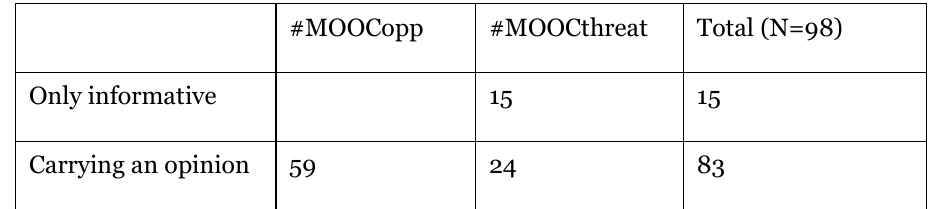
Quantities of Tweets